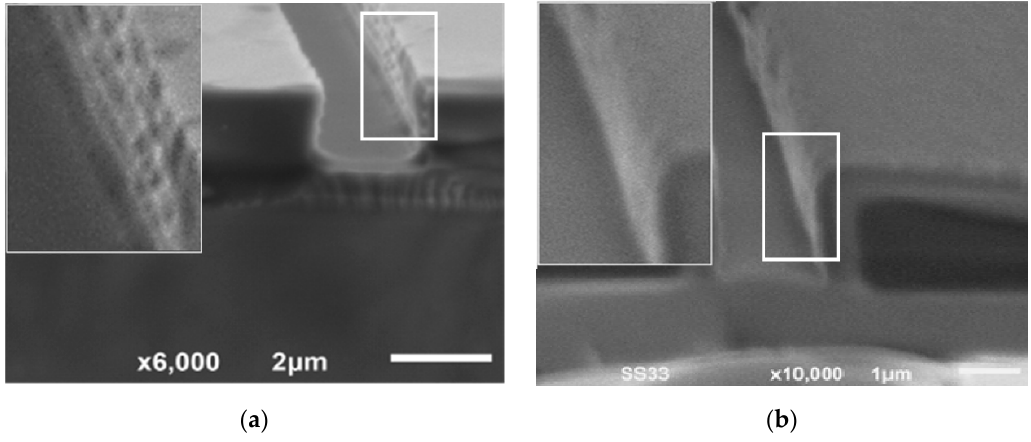
Figure 8. Scallop effect on the silicon vertical wall ( a ) before and ( b ) after oxidation.